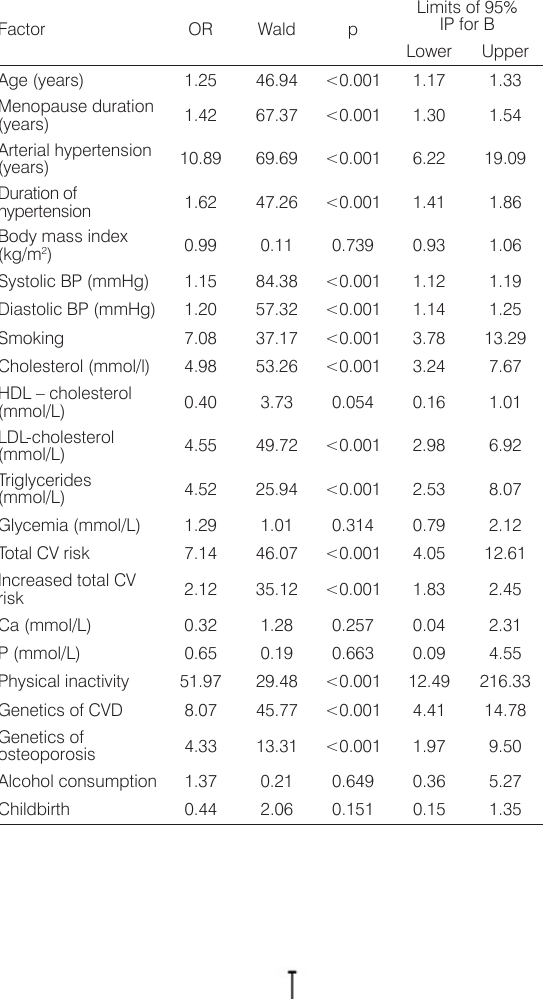
Table 6. OR values for the assessment of the connection of lower bone density (osteopenia and osteoporosis) and risk factors: results of the univariate logistic regression analyses. Factor